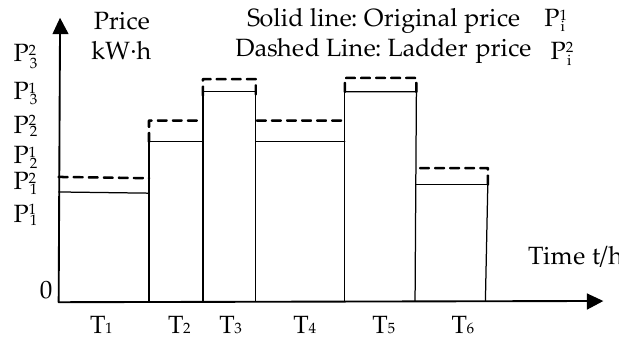
Figure 1. TOU and ladder price electricity price scheme.